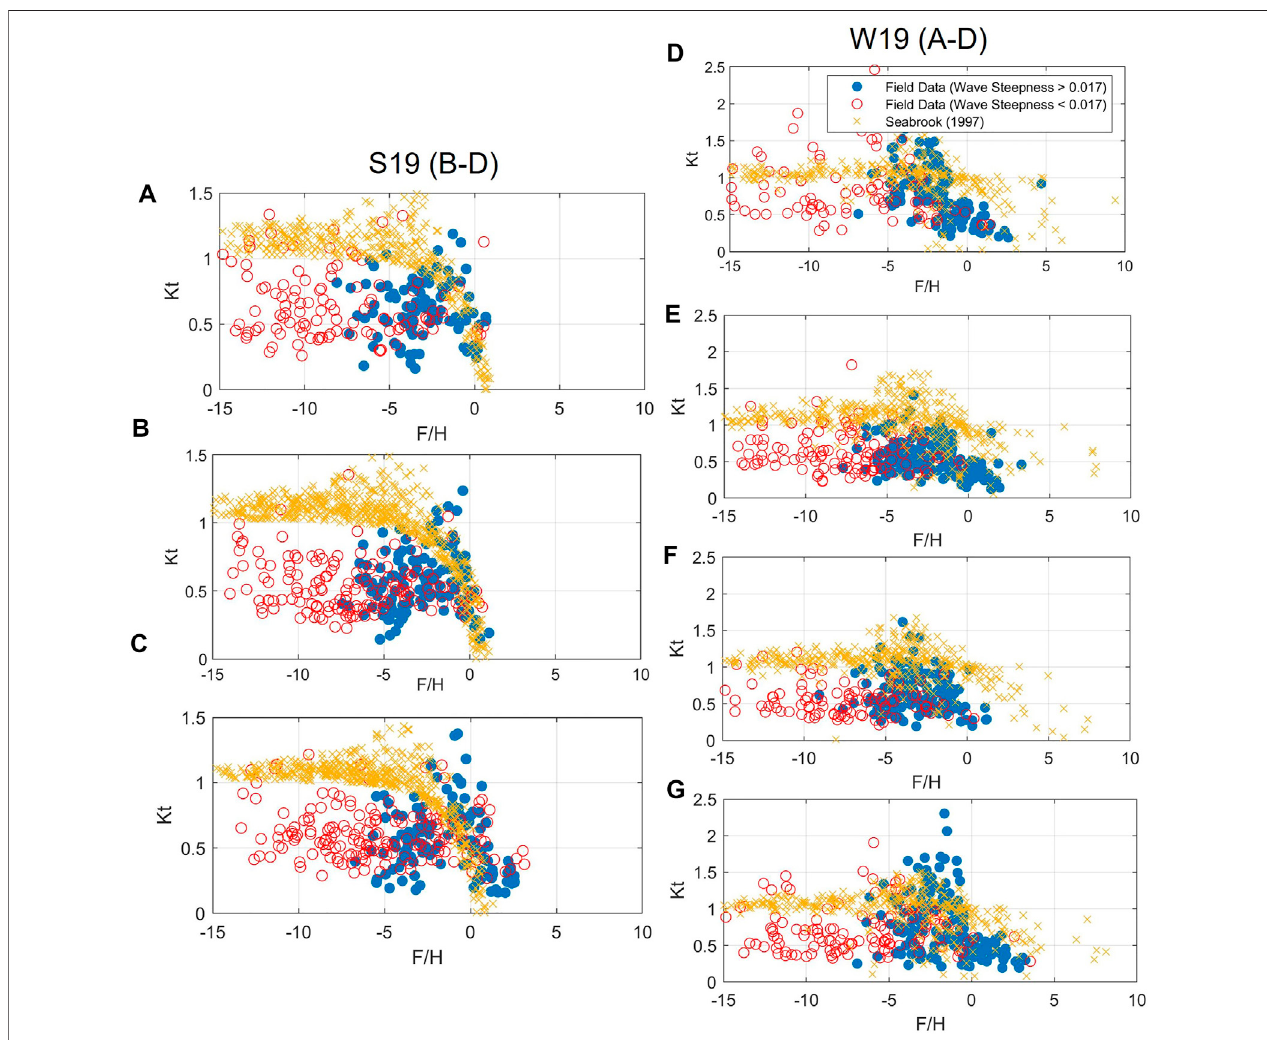
FIGURE7| Wavetransmissioncoef fi cient( K t )vs.relativefreeboard( F / H i )asobservedin fi elddataandmodeledbySeabrookandHall(1998)duringS19 (A – C) and W19 (D – G) and at Site A (D) , B (A,E) , C (B,F) , and D (C,G) . F/H i values greater than 0 indicate structure emergence and values less than 0 indicate submergence. Observeddataisgroupedbyincidentwavesteepnessthresholdofgreaterthan0.017.Waveswithasteepnessgreaterthanthethresholdaremorelikelytobeerosional and potentially contribute more to marsh edge erosion.